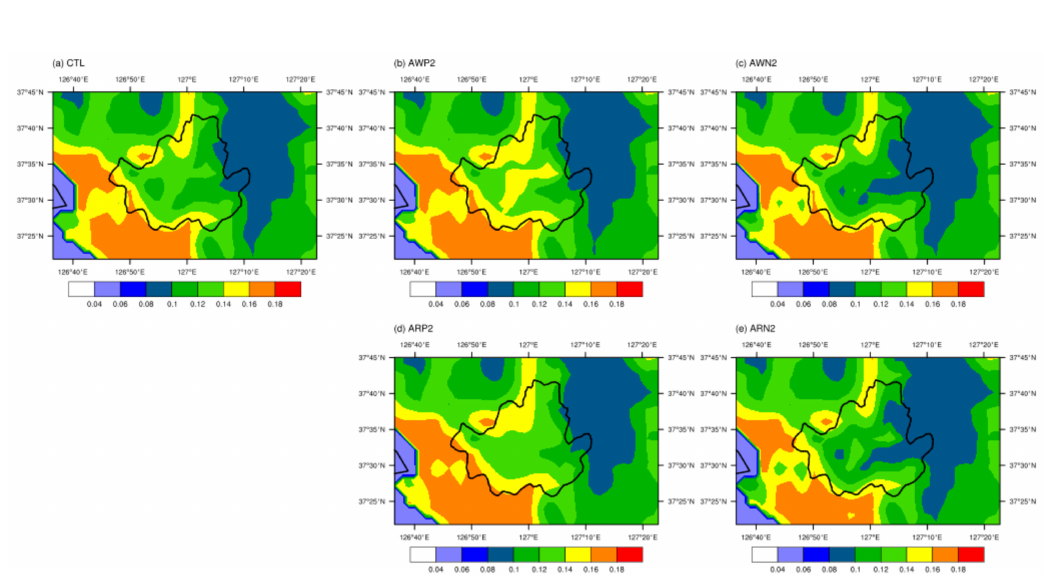
Figure 5. Albedo distribution in ( a ) CTL, ( b ) AWP, ( c ) AWN, ( d ) ARP, and ( e ) ARN.